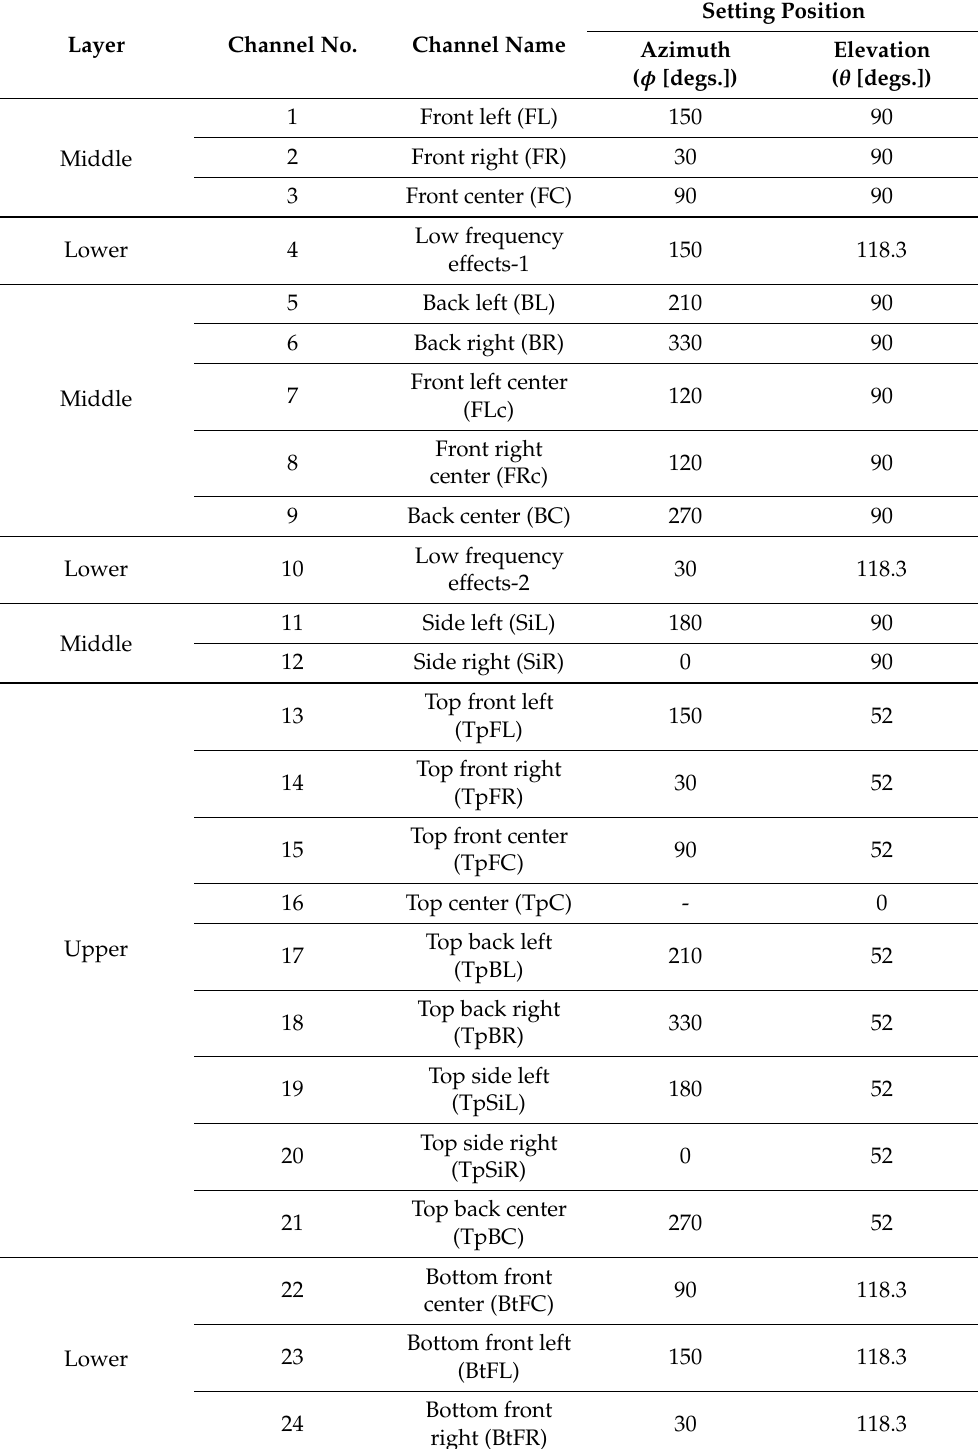
Table 3. Loudspeaker arrangement of 22.2 multichannel audio used in the